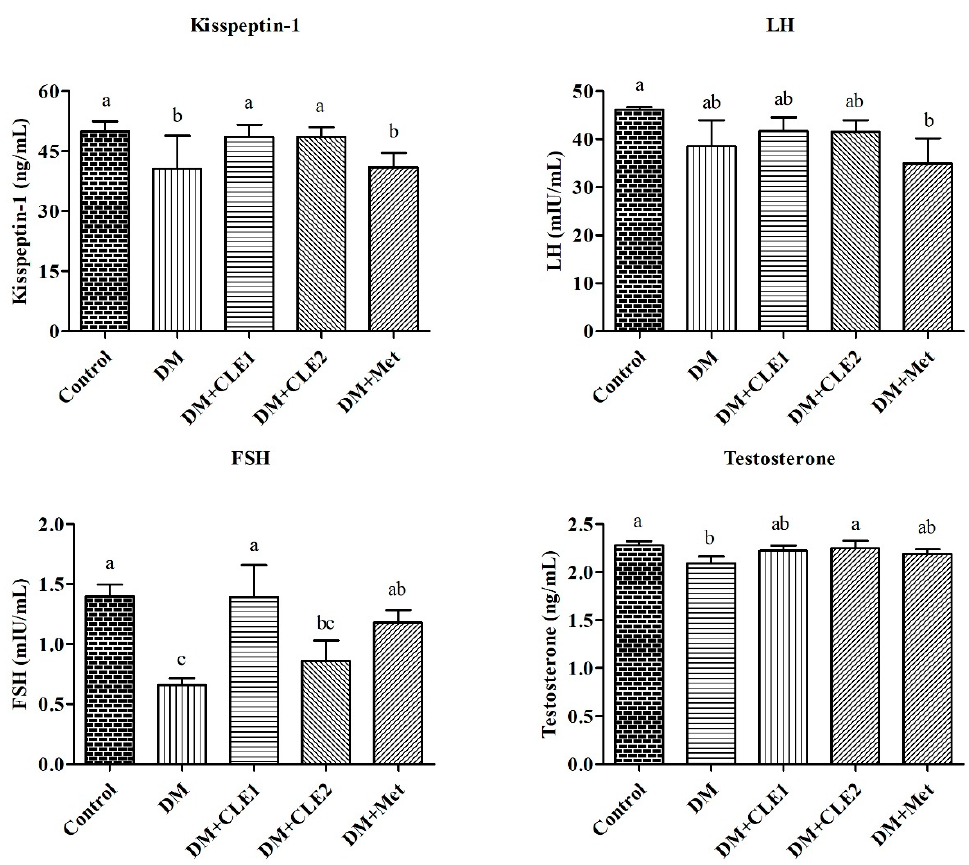
Figure 6. The levels of kisspeptin-1, LH, FSH, and testosterone in the plasma of diabetic mice after treatment for 6 weeks. Data are shown as mean ± SD ( n = 5). The values with different letters (a–c) represented significant difference ( p < 0.05) as analyzed by a Duncan’s multiple range test. DM, diabetes; DM+CLE1, diabetes and 600 mg/kg of C. lentillifera ; DM+CLE2, diabetes and 1000 mg/kg of C. lentillifera ; DM+Met, diabetes and 200 mg/kg of metformin; LH, luteinizing hormone; FSH, follicle-stimulating hormone.